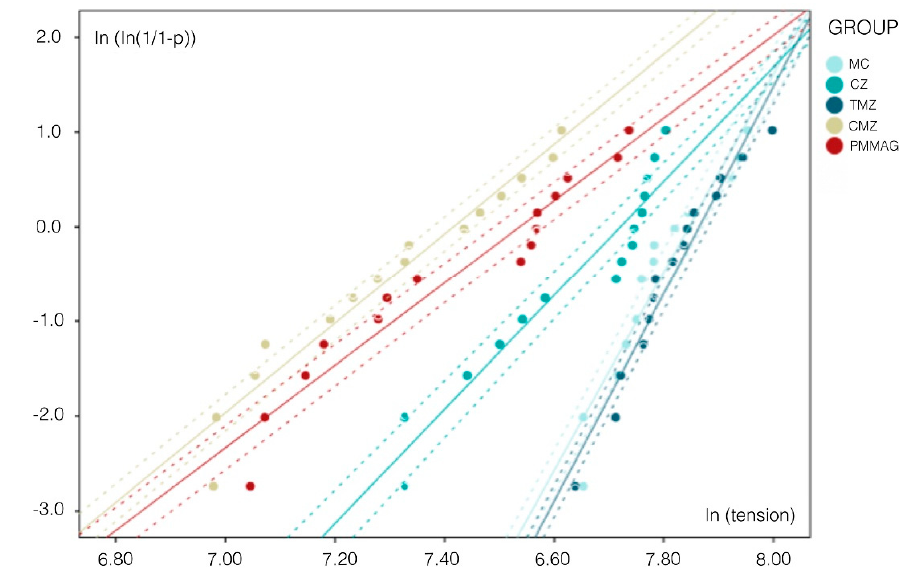
interval Figure 7. Graph showing Weibull Modulus for Groups I, II, III, IV, and V and 95% confidence interval calculated.